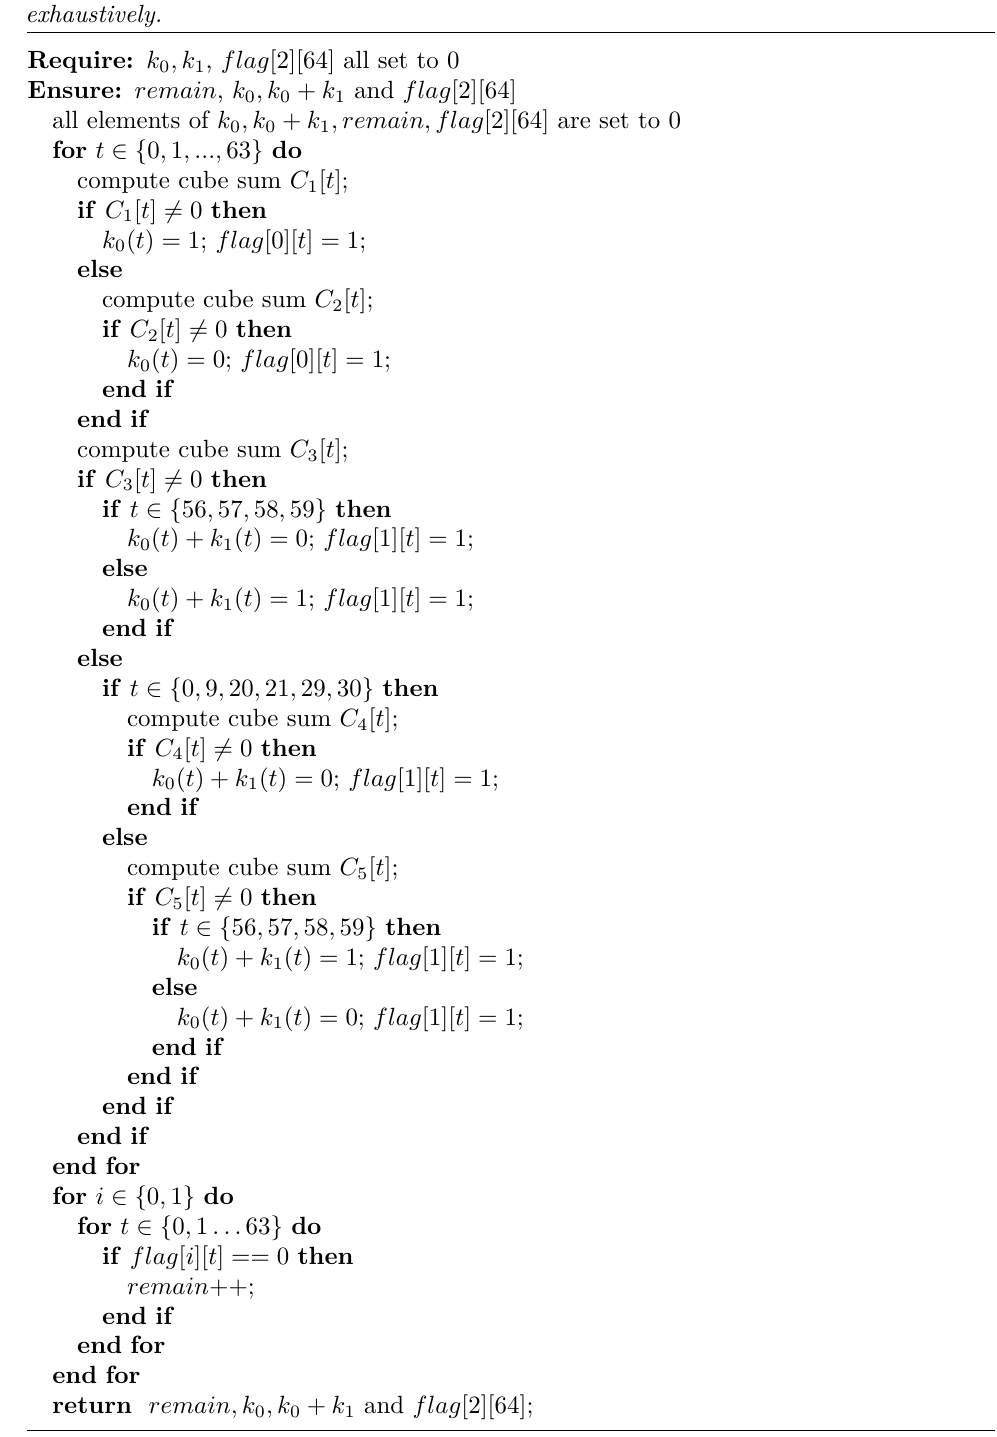
Algorithm 1 Tester in Attack on 5/6-round Initialization of Ascon